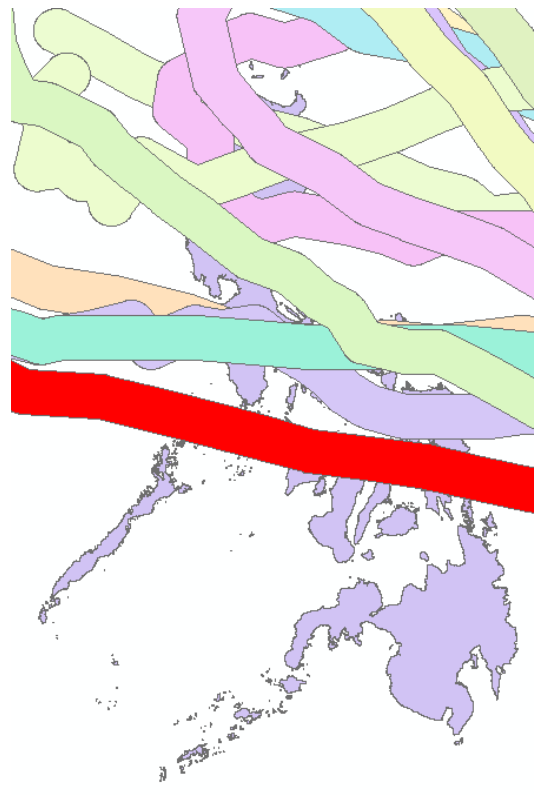
Figure 11. Typhoons with greater than 250 km/h.